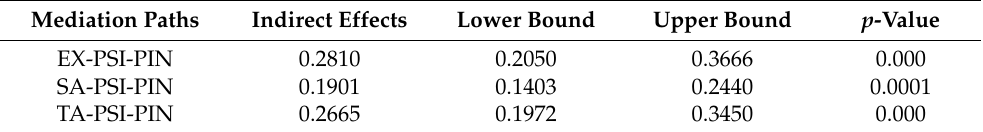
Table 6. The mediating effect